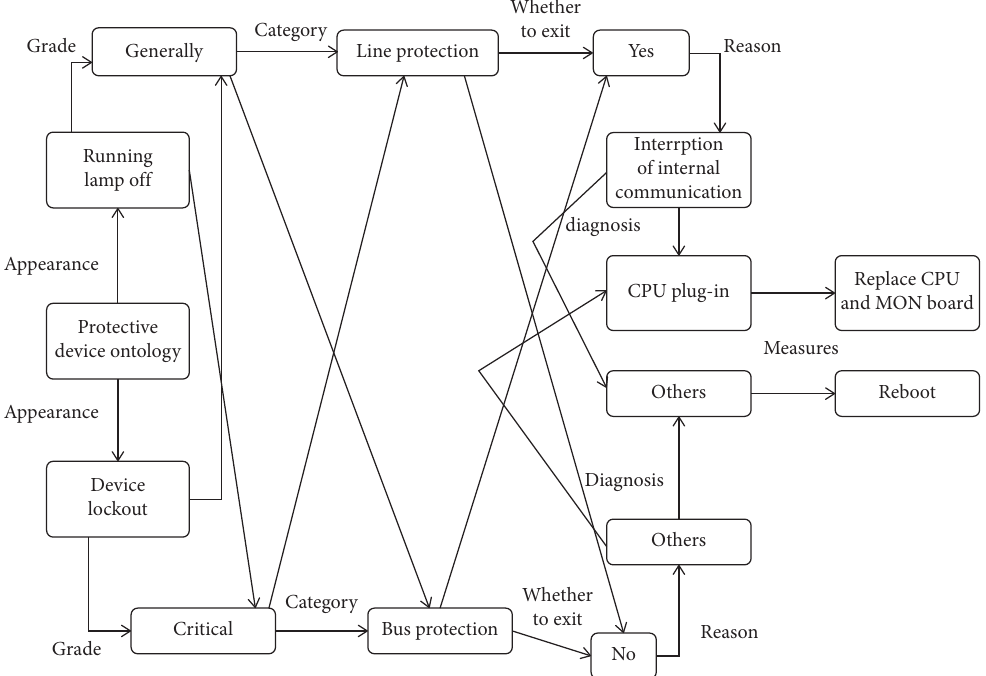
Figure 7: Subgraph of protection device.